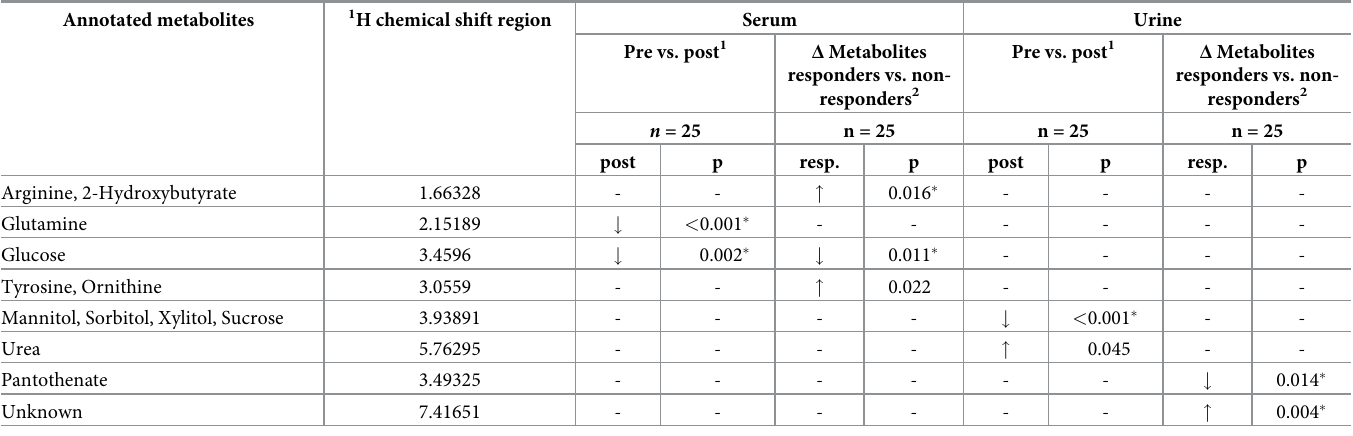
Table 4. Serum and urine metabolites responsible for class discrimination between baseline and endpoint samples, and between responders and non-responders in the low FODMAP diet. Annotated